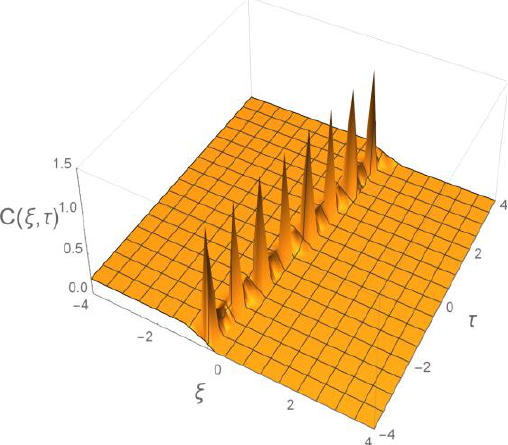
Figure 4. Our 3D representation of the train of spikes according to model described in Zahran [42]. Dimensionless space-time variables are: = x (cid:96) ; τ = vt (cid:96)